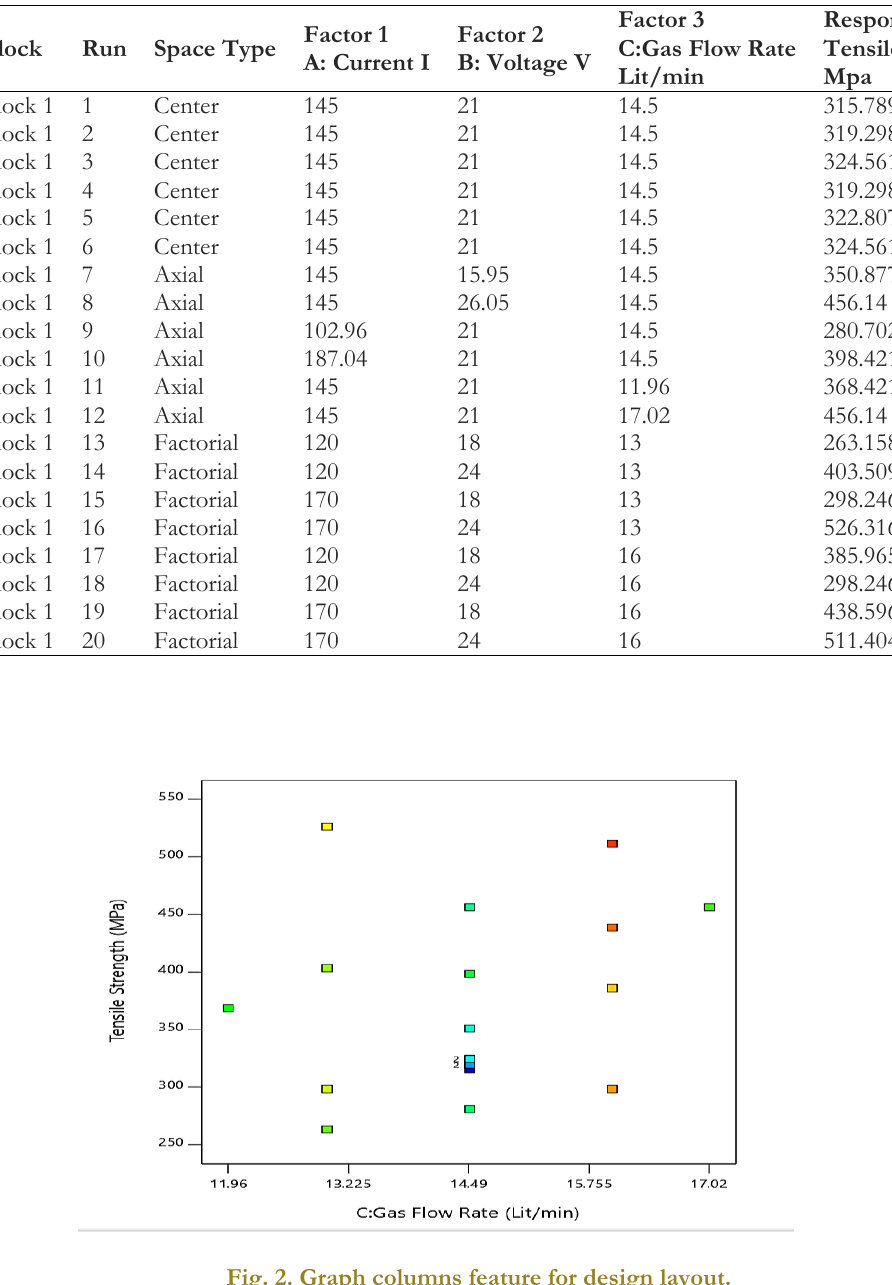
Fig. 2. Graph columns feature for design